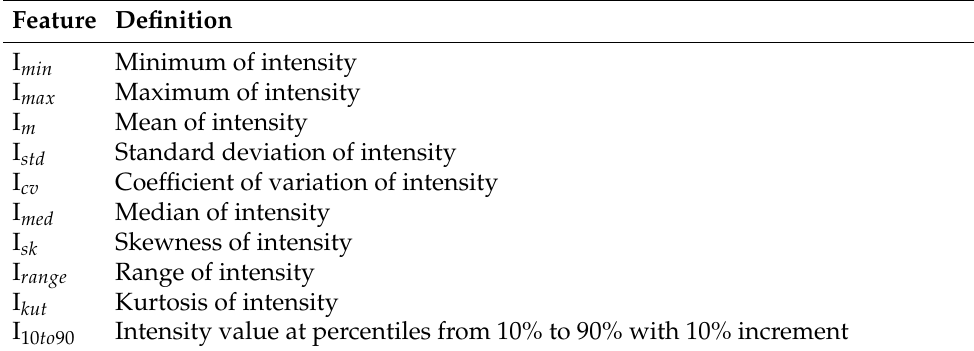
Table 2. Single-channel intensity features derived from LiDAR